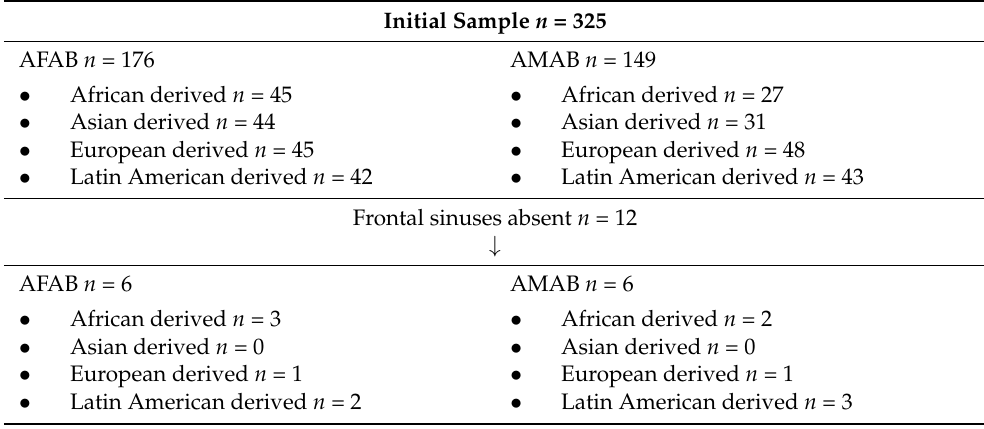
Table 1. Sample sizes used in dimensional and morphological